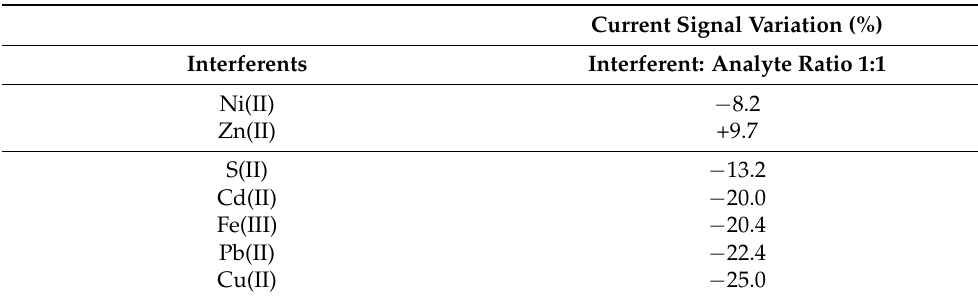
Table 6. Effects of additions of some interferents on the LSV signals of 3.33 mol L − 1 of urea